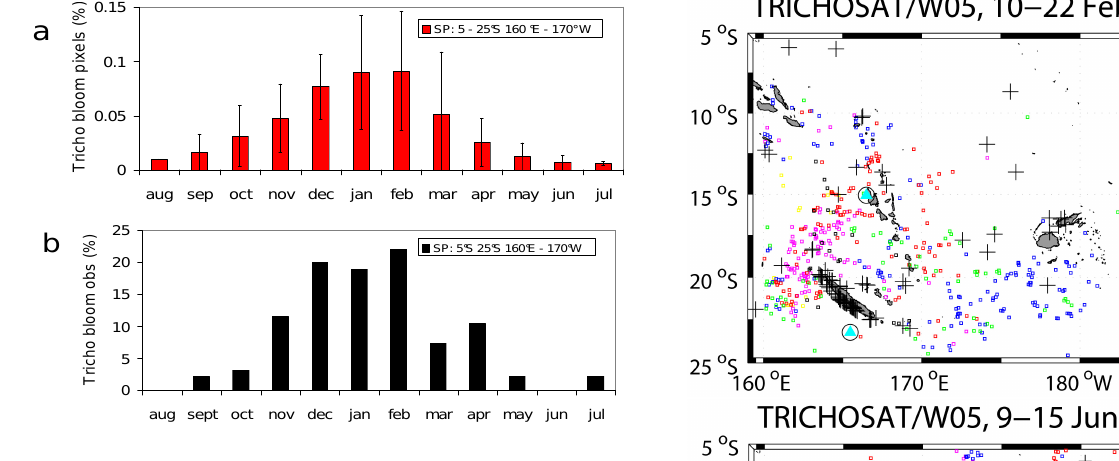
Fig. 8. (a) Histogram representing the mean annual cycle of per- centage Trichodesmium bloom pixels ( ± 1 σ ) over the 12 years (1998–2010) of the SeaWiFS acquisition period; (b) Histogram rep- resenting the mean annual number of in situ slick observations (Nb, from Table 1).